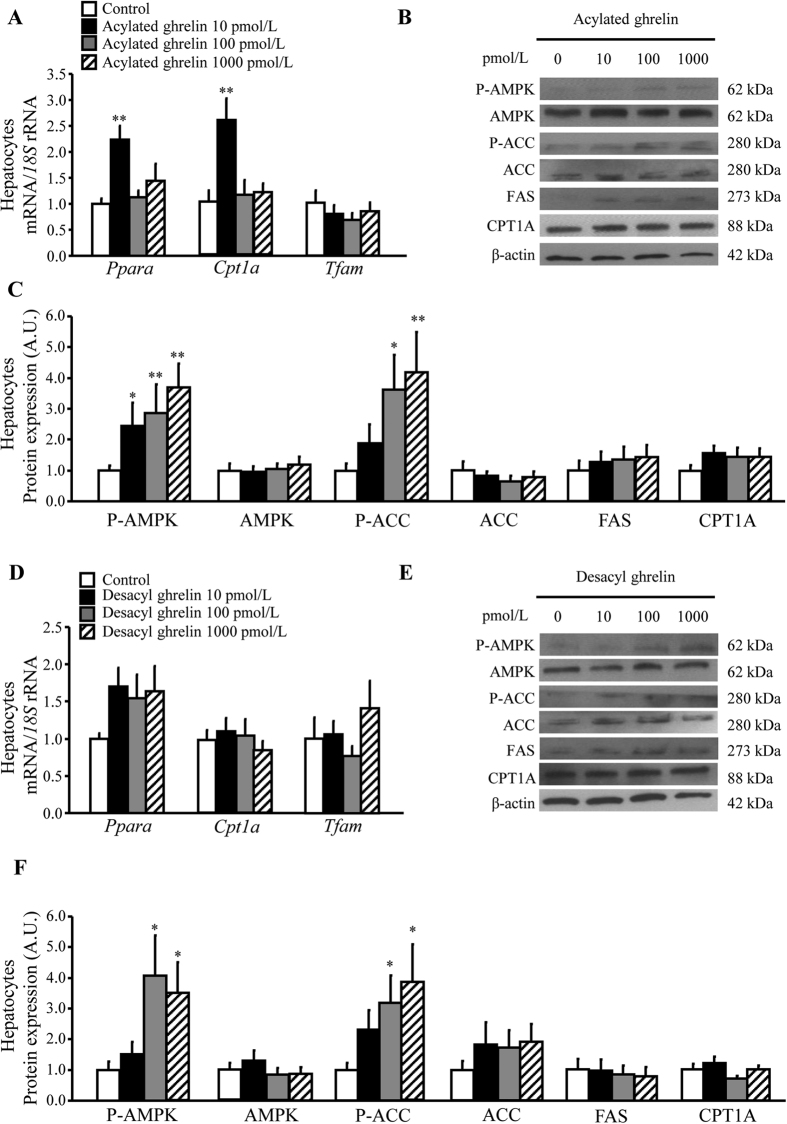
Effect of acylated and desacyl ghrelin on mitochondrial biogenesis and FFA β-oxidation.Bar graphs show the effect of acylated (A) and desacyl (D) ghrelin on the expression of molecules involved in mitochondrial biogenesis (Tfam) and FFA β-oxidation (Ppara and Cpt1a). Representative cropped blots and Western-blot analysis showing impact of acylated (B,C) and desacyl (E,F) ghrelin on P-AMPK/AMPK and P-ACC/ACC ratios as well as the basal expression of AMPK, ACC, FAS and CPT1A enzymes in primary cultures of rat hepatocytes. The gene and protein expression in unstimulated hepatocytes was assumed to be 1. *P < 0.05; **P < 0.01 vs unstimulated hepatocytes.